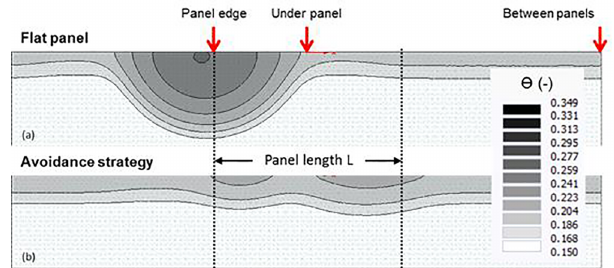
Figure 12. Simulation of soil water patterns with Hydrus-2D, in regions located near the aplomb of the panel’s edge, under panels or between panels, when holding the panels flat (a) or operating them according to the avoidance strategy (b) to reduce the heterogeneity of rain redistribution by the panels during event #11 (see Tables 3 and 4). The vertical arrows recall the positions of the neutron probes used to collect water content data plotted in Fig. 11.